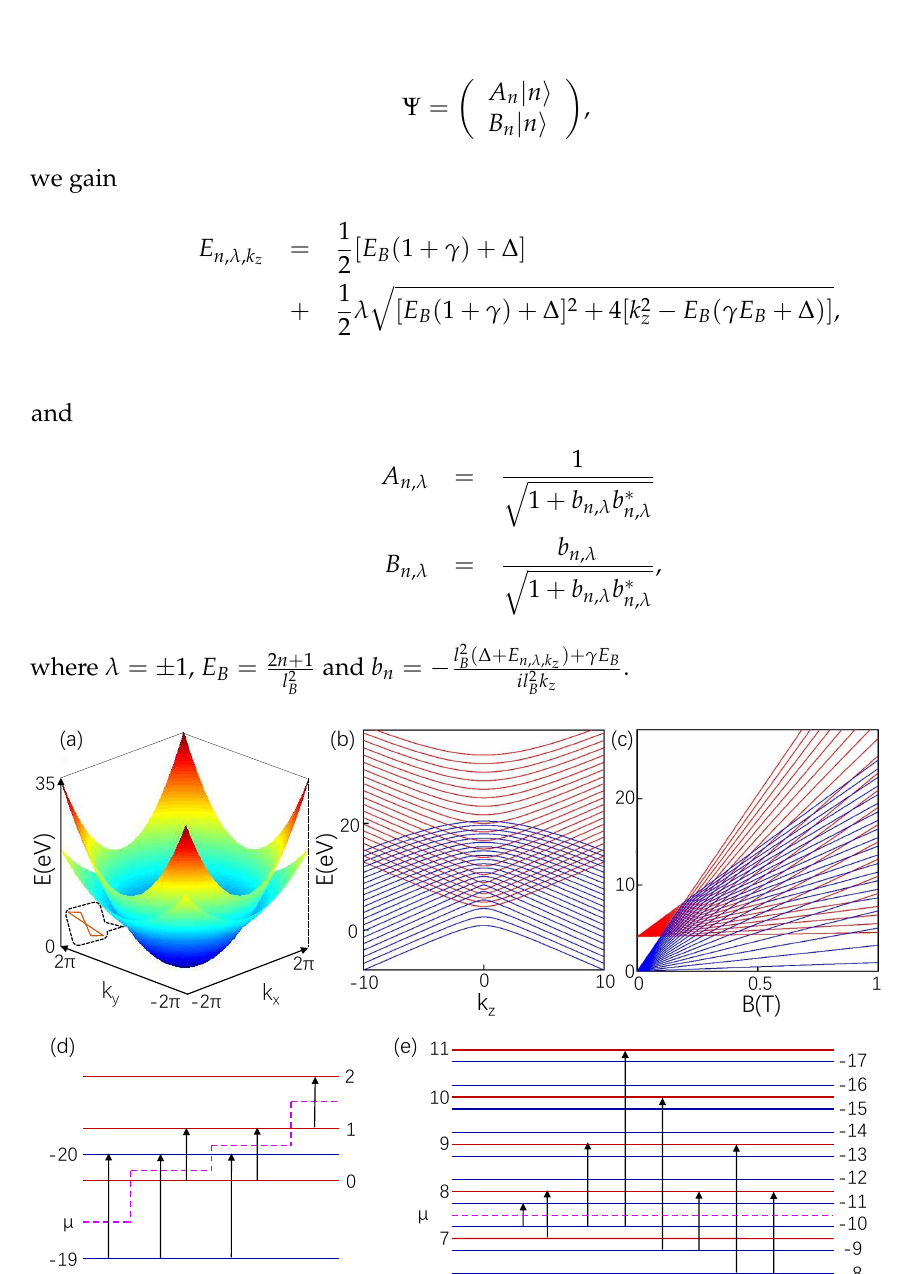
Figure 1. ( a ) The low energy dispersion of type-II NLS at k z = 0. Two cones with different slopes form type-II NLS. ( b ) is LLs structure along k z at B = 0.8 T. ( c ) The LLs as a function of B at k z = 0 by Equation (4). Allowable optical transitions are indicated by black arrows. ( d ) Only intraband transition are marked in LLs for B = 0.1 T. ( e ) is for B = 0.8 T and µ = 12.8 eV. The red (blue) LLs represent positive (negative) branch, denoted by n ≥ ( ≤ ) 0 index. The dotted pink line represents the position of the chemical potential. The parameters N = 20, γ = 0.5, ∆ = 4 eV, and e = 1. [ E ( 1 + γ ) + ∆ ] ± 1 | E ( 1 − γ ) − ∆ | at k = 0. E = γ E + ∆ We get E n , λ = 1 z B B B n , +( − ) 2 2 = E < ( > ) ∆ and E . The characteristics of LLs dependent on B , with B n , − (+) e ( 2 n + 1 )( 1 − γ ) magnetic field B at k z = 0 are displayed in Figure 1c. We define the positive (negative) branch is represented by red (blue) line. For LLs, a specific LL is represented by the n , and the maximum value about LLs uses the sign the N . We find that LLs not only have the phenomenon of slope changing, but the most interesting feature is asymmetry. Before